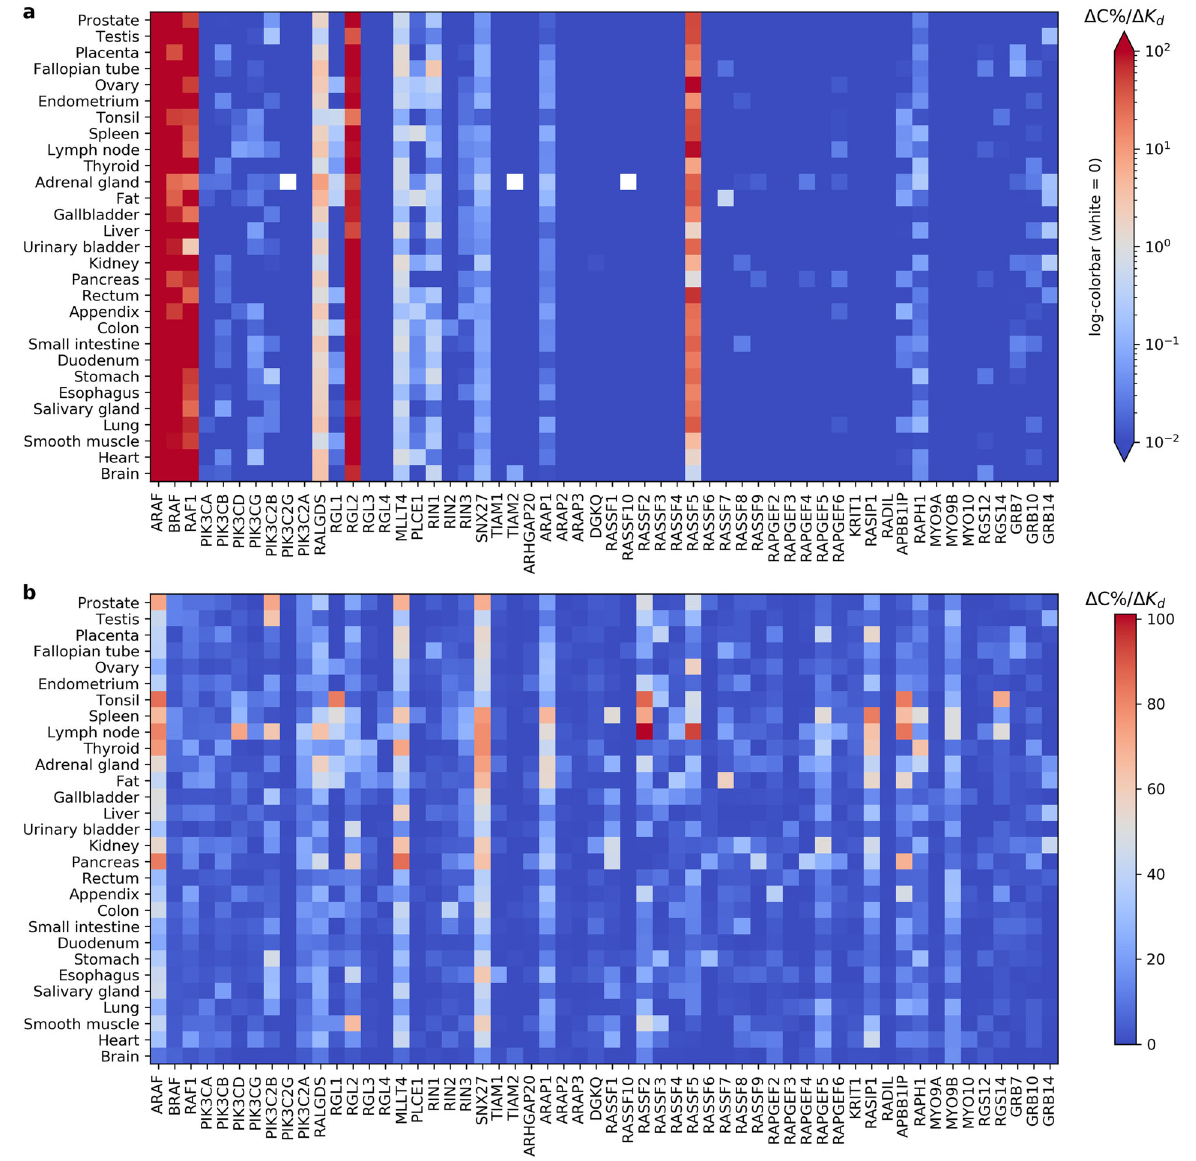
Fig. 5 Binding af fi nity sensitivity analysis. Local ( a ) and global ( b ) one-at-a-time perturbation of the parameter K d , dissociation constant of the Ras-effector complexes, in 29 tissues. The heatmaps show the change in the output Δ C (%) to the change of the input Δ K d spanning ( a ) in the interval [ K d − 10%, K d + 10%] and ( b ) in the interval [0.04,0.527]